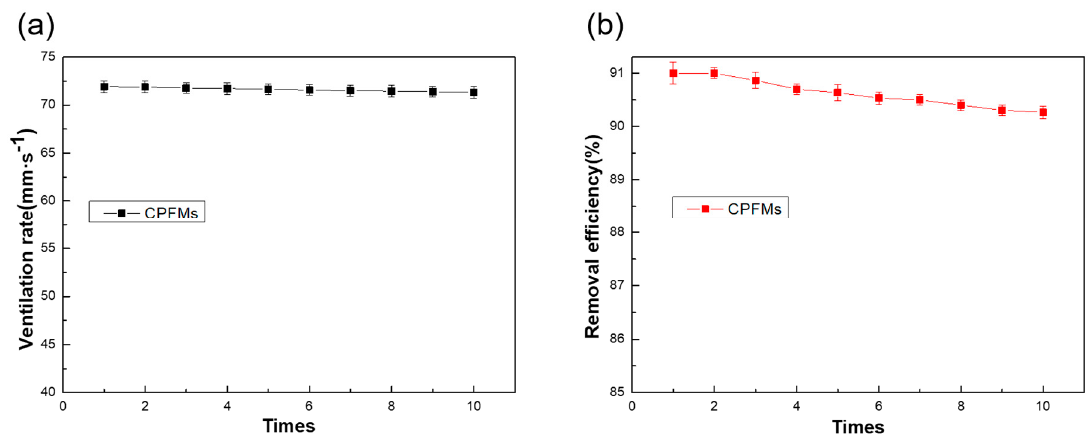
Figure 10. Reproducibility of the ventilation rate and removal efficiency of the composite fiber membrane. ( a ) Reproducibility of the ventilation rate. ( b ) Reproducibility of the removal efficiency.